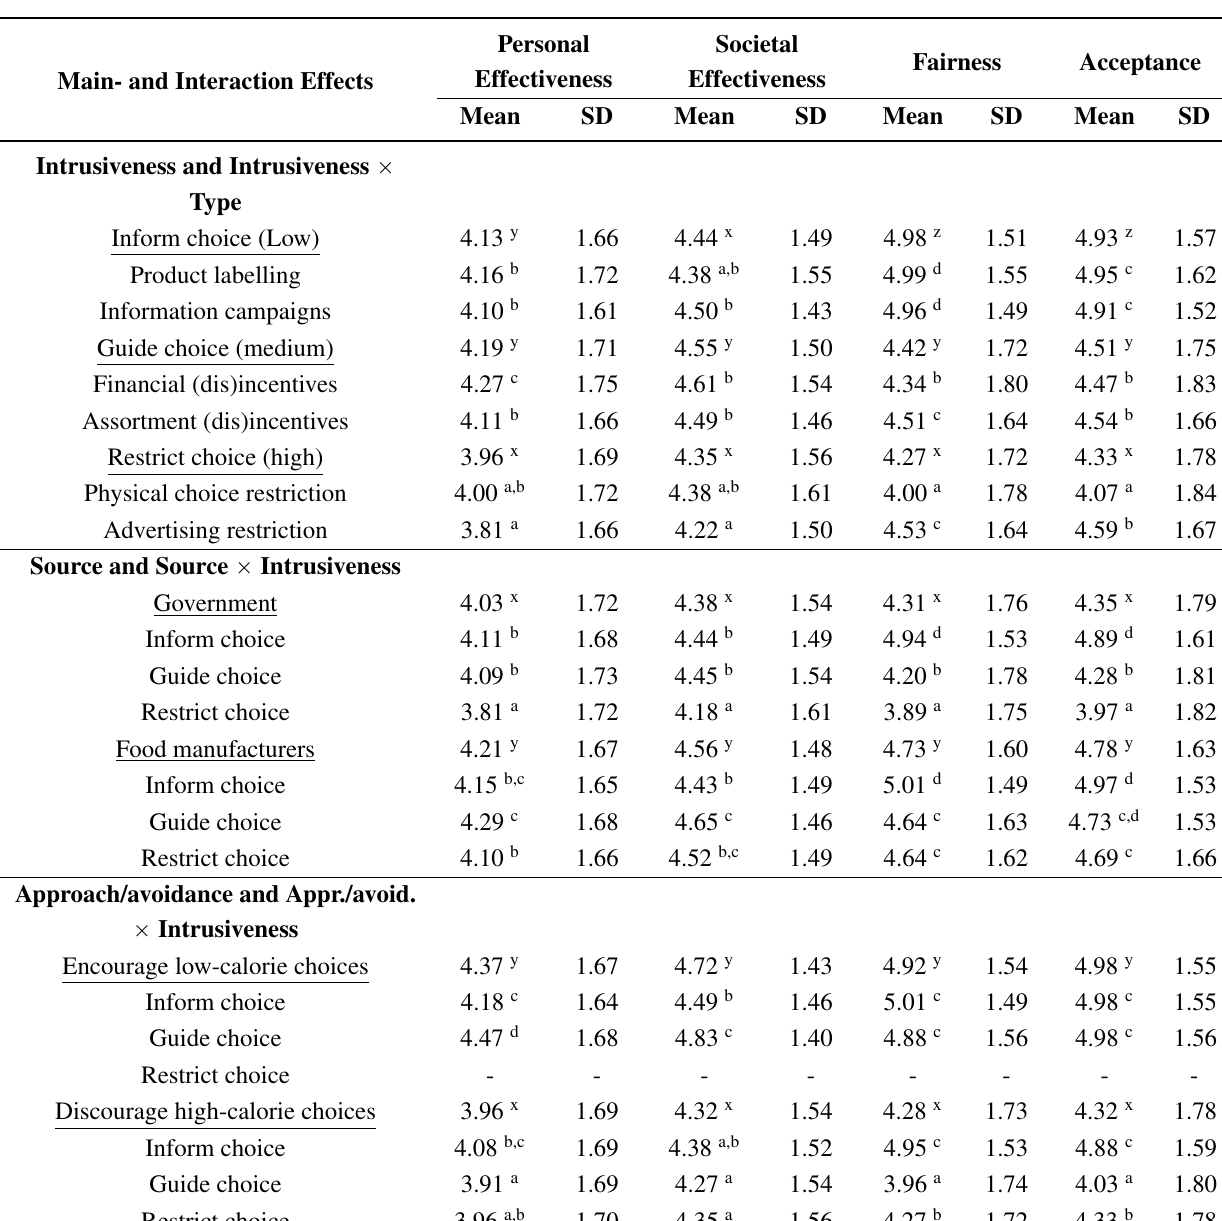
Table 6. Means of the effect sizes (partial η 2 > 0.015) for snack food interventions. Main- and Interaction